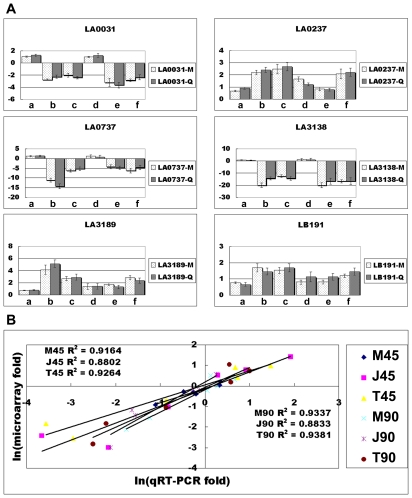
Validation of microarray data using quantitative real-time RT-PCR.The transcriptional levels for the randomly selected 6 genes (Table S1) were determined by quantitative real-time RT-PCR using new batch of RNA samples (A). M: the mRNA change folds from normalized microarray data; Q: the mRNA change folds from normalized qRT-PCR data; a, b, c, d, e, and f: the mRNA change folds of M45, J45, T45, M90, J90 and T90. No PCR amplification was detected in negative controls. The quantitative real-time RT-PCR values were plotted against the microarray data values. The high correlation coefficient values (R2) indicated that the microarray signal represented by multiple oligonucleotide probes was valid for transcriptomics research (B).